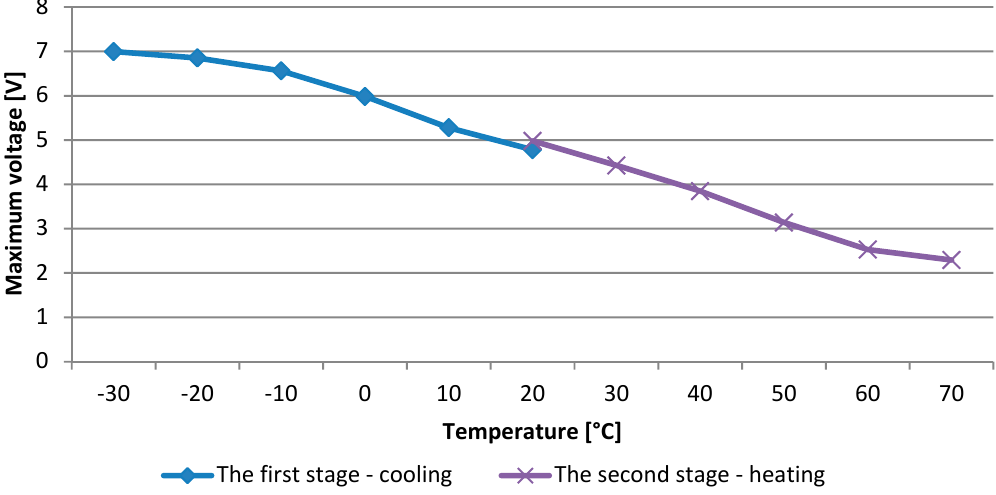
Figure 4. The dependence of the maximum voltage on the connected resistor as a function of the operating temperature of the tested system.